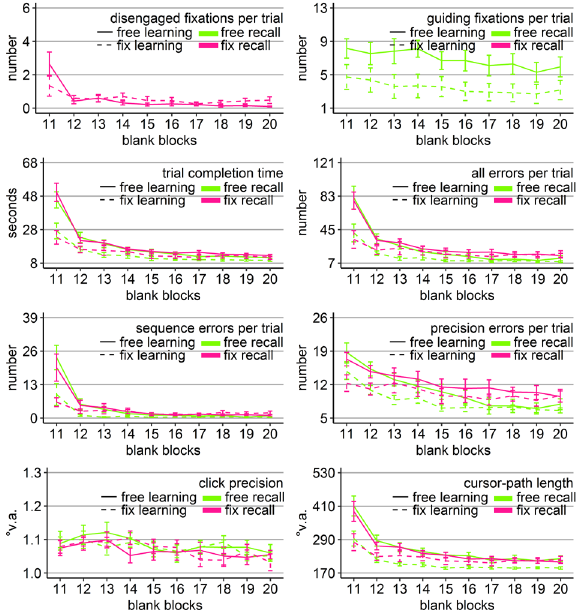
Figure 7. Gaze and performance measures during the recall phase of Experiment 3. The top left plot shows how often participants, who were asked to keep central fixation, disengaged their fixation per trial (y-axis) over the course of the ten blank blocks (x-axis) depending on whether they learned the clicking sequence with free gaze (solid line) or with fixed gaze (dashed line). The top right plot shows how many guiding fixations participants, who were allowed to move their eyes freely, performed per trial (y-axis) during the ten blank blocks (x-axis) depending on whether they had learned the clicking sequence with free gaze (solid line) or with fixed gaze (dashed line). The six bottom plots show the six performance measures trial completion time in seconds, numbers of all errors, sequence errors, and precision errors per trial, click precision in °v.a., and cursor-path length in °v.a. (y-axes) over the course of the ten blank blocks (x-axes) for the four group combinations of recall with free gaze (green lines) or fix gaze (pink lines) after learning with free gaze (solid lines) or fix gaze (dashed lines). Error bars represent standard errors of the